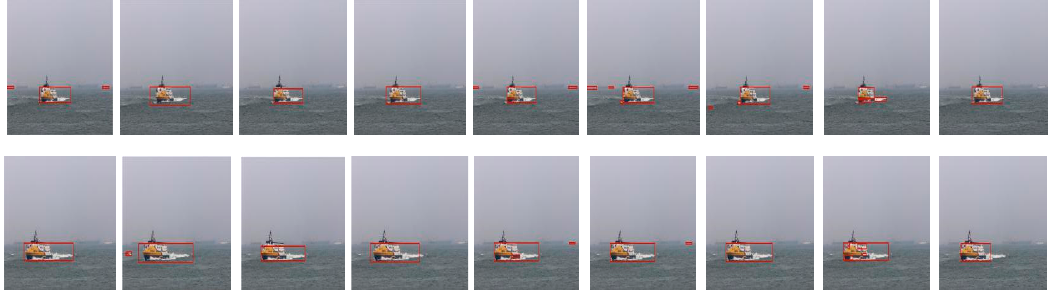
Figure 5. Sea surface image saliency target segmentation results for different algorithms. Columns 1–9 shows the images processed using the RWRV, AIM, DRFI, CA, SC, HC, SD, FT and proposed algorithms, respectively.